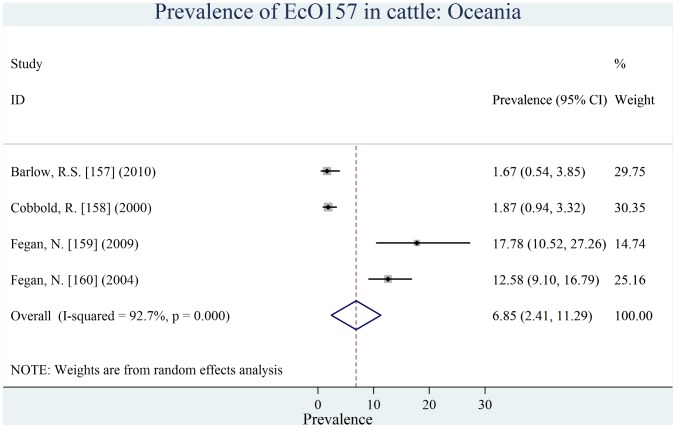
Forest plot of prevalence of E. coli O157 in cattle amongst studies conducted in Oceania.